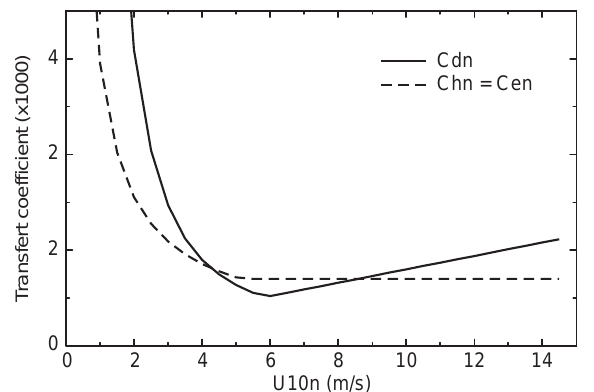
Fig. 2. Trajectory of the center of the pressure low between 27 October and 1 November. The analyzed sea level pressure field is displayed in the simulation domain for the 30 Oct 18